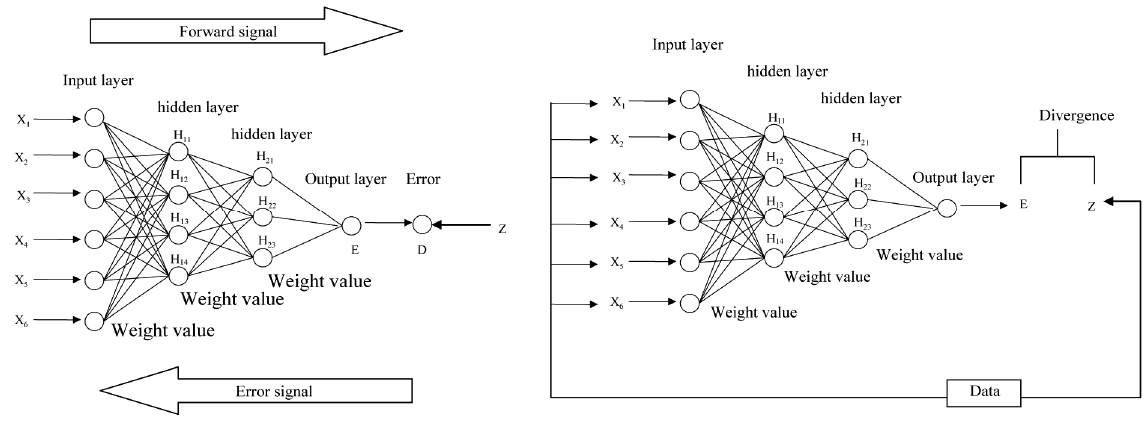
Fig. 4. Error-back-propagation Neural